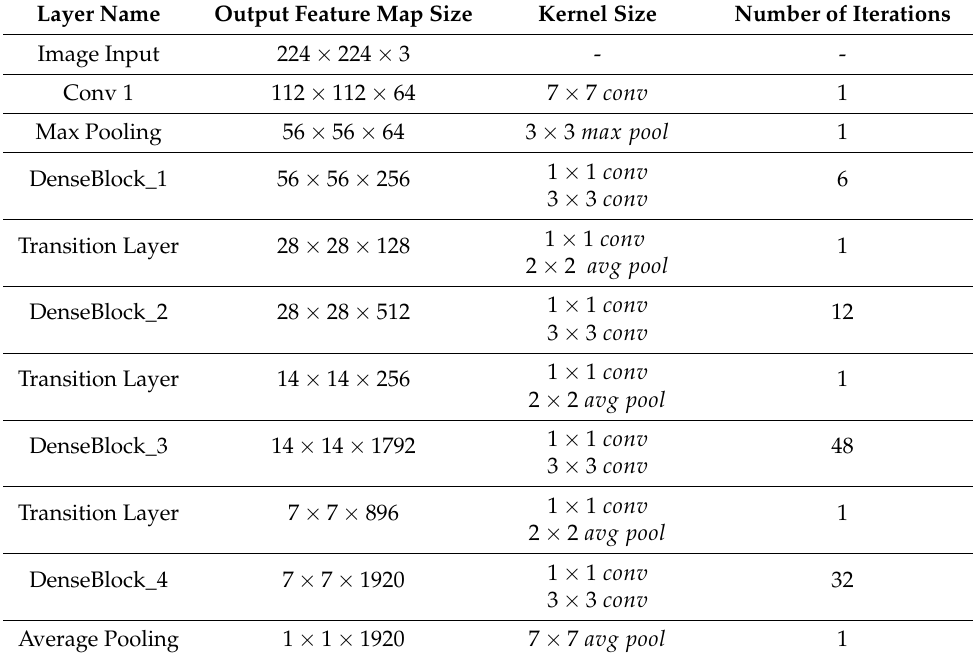
Table 3. Layer configuration details of modified